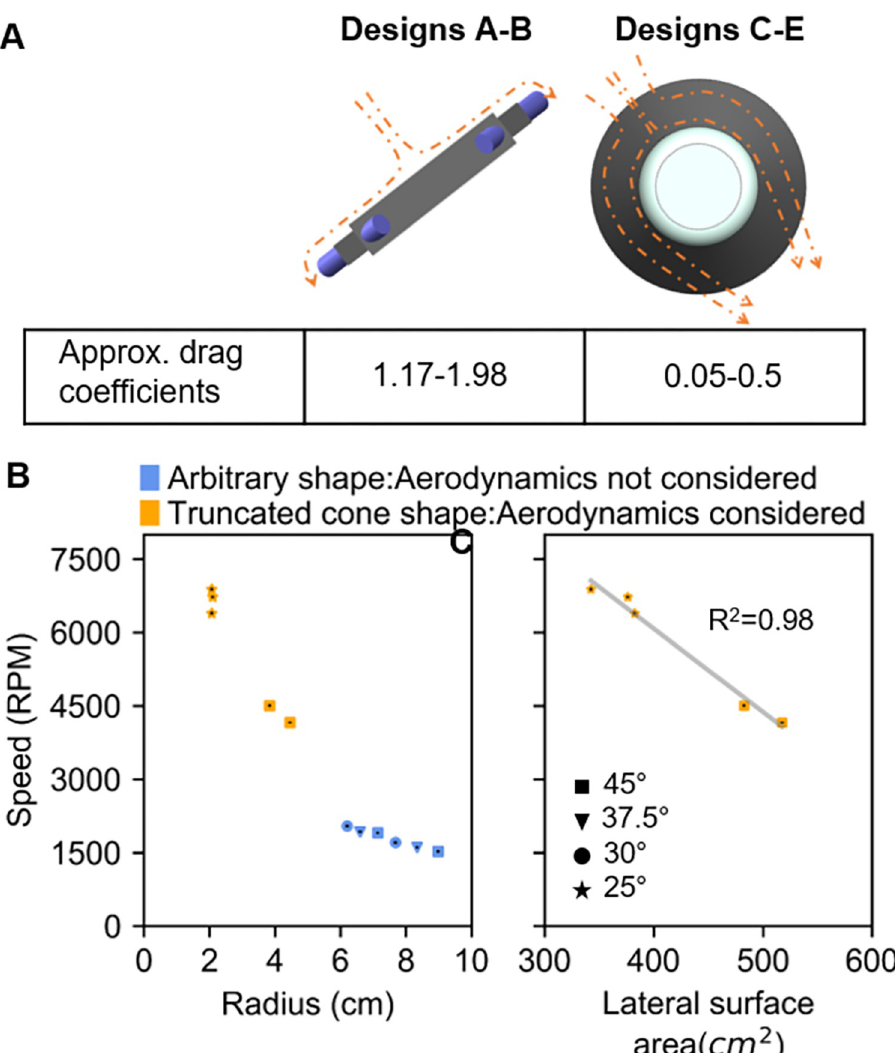
Fig 4. Influence of design shapes and sizes on speed (A) Schematic diagram showing an arbitrary shape design provides higher aerodynamic drag force than the truncated cone shape design by resisting much of the surrounding airflow. For simplicity, airflow is showed only in one direction instead of all sides. (B) Radial distance of all designs vs their rotational speed (C) Lateral surface area of the truncated cone-shaped designs vs their rotational speed. NB: Both the panel B and C share the same